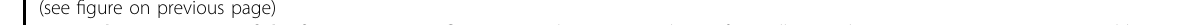
Fig. 3 Characterization of the four tumor-speci fi c TFs. a Kaplan – Meier analyses of overall survival in TCGA-KIRC patients separated by HOXC5 , VENTX , ISL1 , and OTP expression (with the median value as the threshold) individually. HR, hazard ratio. b TF regulatory network showing the candidate target genes for the following TFs: HOXC5 , VENTX , ISL1 , and OTP in tumor cells. c The effects of sh- HOXC5 , VENTX , ISL1 , OTP , and vector on cell proliferation were determined by a cell proliferation assay in the 786-O cell line. d HOXC5 , VENTX , ISL1 , and OTP mRNA expression were signi fi cantly downregulated in the 786-O cell line. Signi fi cance was determined by two-way ANOVA. e Heatmap showing the degree of decrease in expression levels of VENTX , ISL1 , and HOXC5 after drug treatment. f Cell proliferation was assessed over a 2-day time course after treatment with DMSO or HHT in the 786-O (top) and 769-P (bottom) ccRCC cell lines. Signi fi cance was determined by multiple t- tests. g The mRNA levels of HOXC5 after treatment with DMSO or HHT in the 786-O (left) and 769-P (right) ccRCC cell lines were measured using qPCR. Signi fi cance was determined by Student ’ s t -test. h Cell proliferation was assessed over a 2-day time course after treatment with DMSO or mitotane in the 786-O (top) and 769-P (bottom) ccRCC cell lines. Signi fi cance was determined by multiple t -tests. i The mRNA levels of VENTX after treatment with DMSO or mitotane in the 786-O (left) and 769-P (right) ccRCC cell lines were measured using qPCR. Signi fi cance was determined by Student ’ s t -test. j The mRNA levels of ISL1 after treatment with DMSO or mitotane in the 786-O (left) and 769-P (right) ccRCC cell lines were measured using qPCR. Signi fi cance was determined by Student ’ s t -test. For all statistical tests, * P < 0.05; ** P < 0.01; *** P <